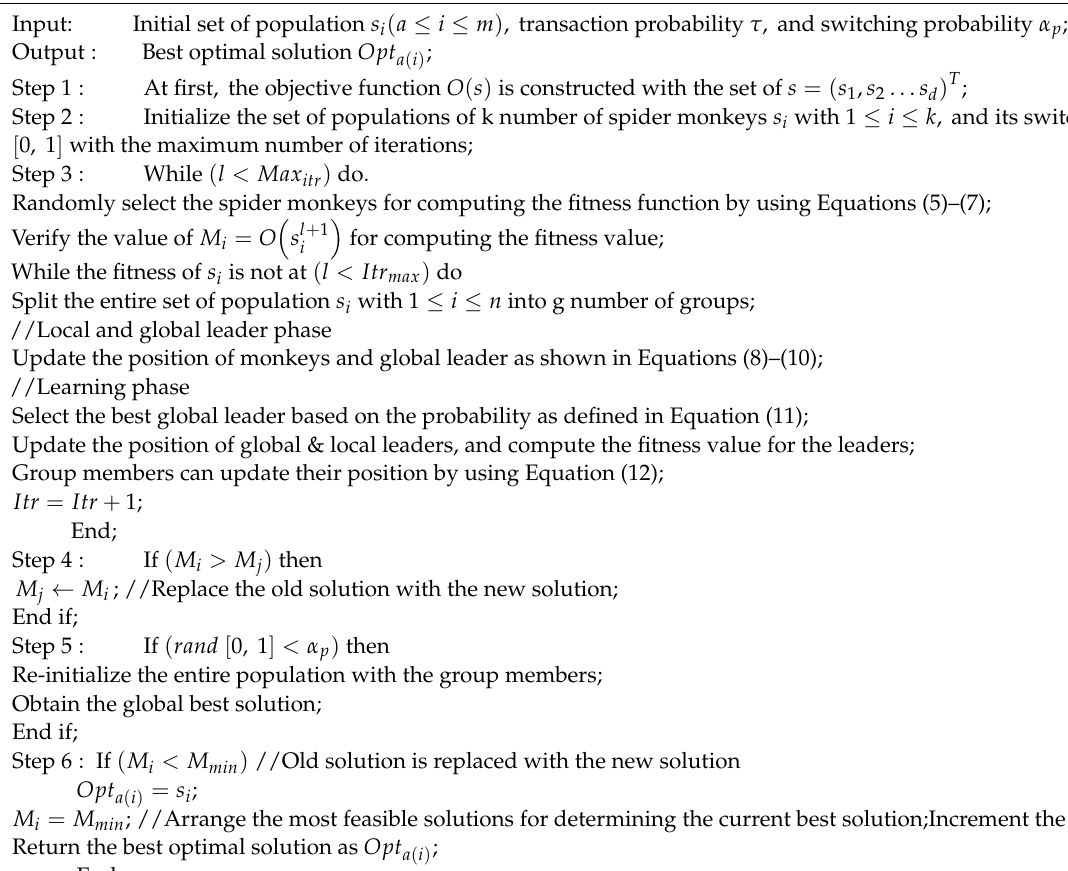
Algorithm 1 Gradient Descent Spider Monkey Optimization